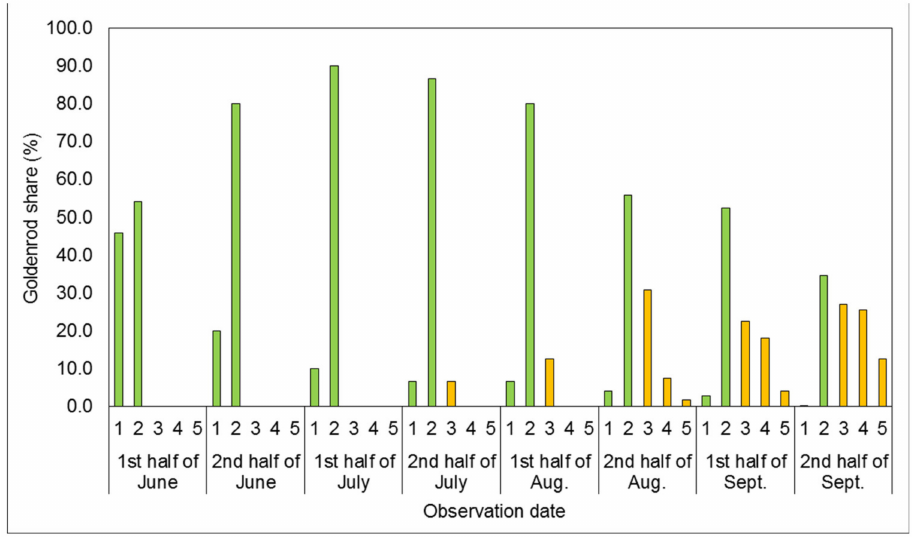
Figure 4. Mean share of goldenrods in successive developmental stages covering the plots’ surfaces in the one-time mowing with one-time rotary tiller treatment (1M + 1RT). In Figures 1–5, vegetative stages are marked green, while generative stages are orange, and the numbers mark the successive stages of the goldenrods’ development: (1) emergence and early vegetation, (2) development of shoots, (3) formation of inflorescences, (4) flowering, and (5) fruiting and shedding of achenes.